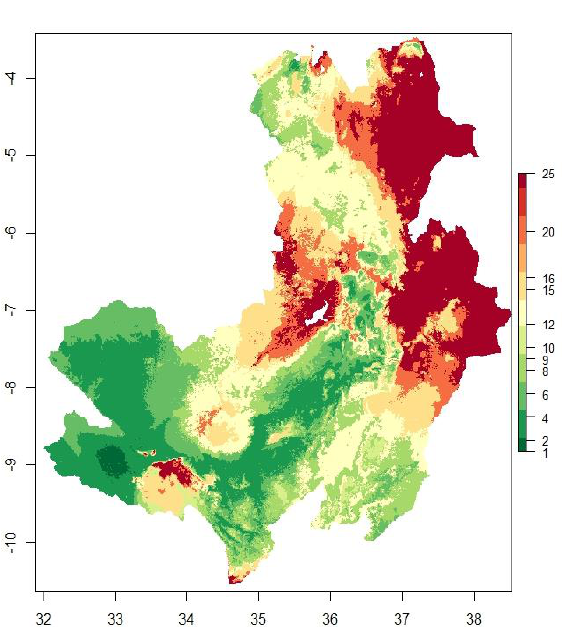
Figure 6. Map on most important covariate (MIC).